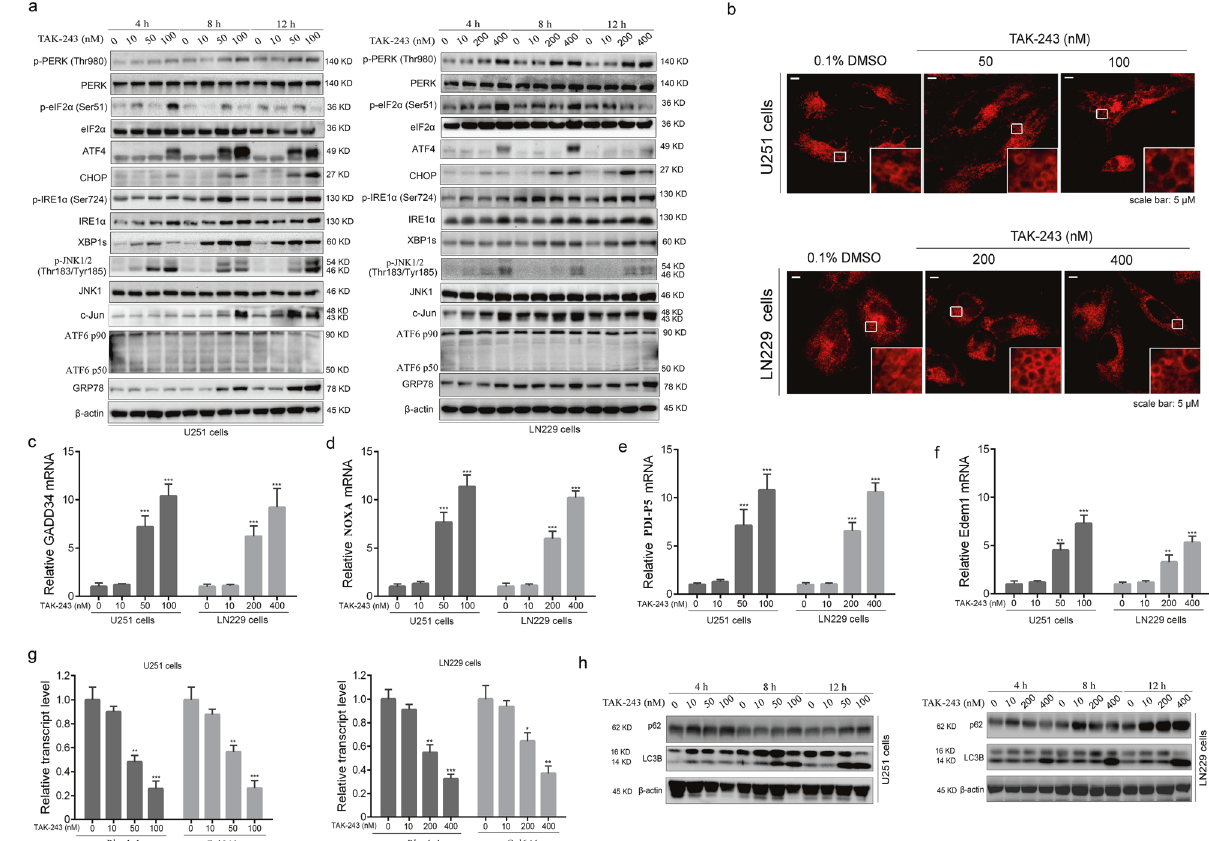
mRNA level of Bloc1s1 and Col6A1 , which are downstream genes of RIDD pathway. h Western blotting showing the expression levels of p62 and LC3B